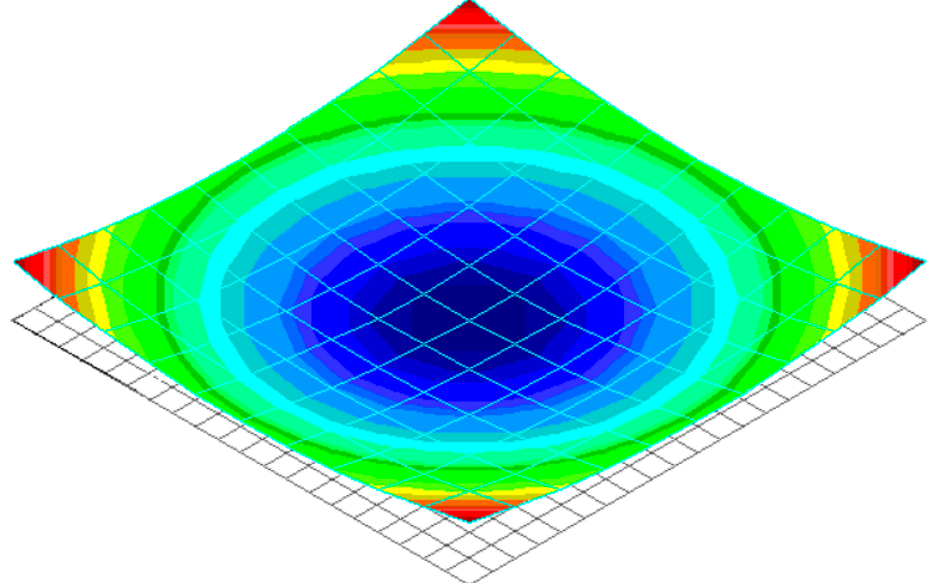
Figure 4. General view of deflection of the panel with symmetric reinforcement structure because of uneven heating across the thickness.